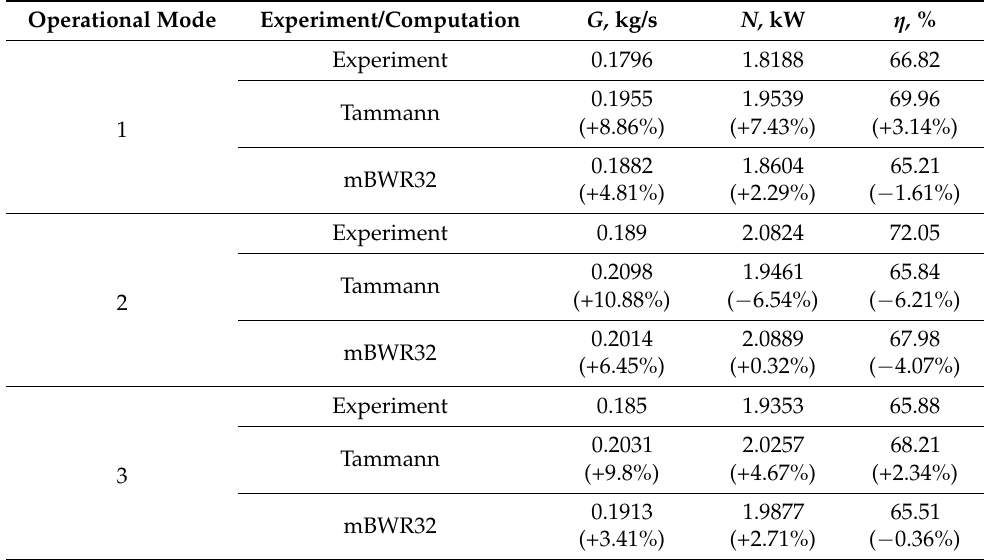
Table 6. Comparison of experimental and calculated microturbine flow rate, power, and efficiency for given operational regimes as defined in Table 4.